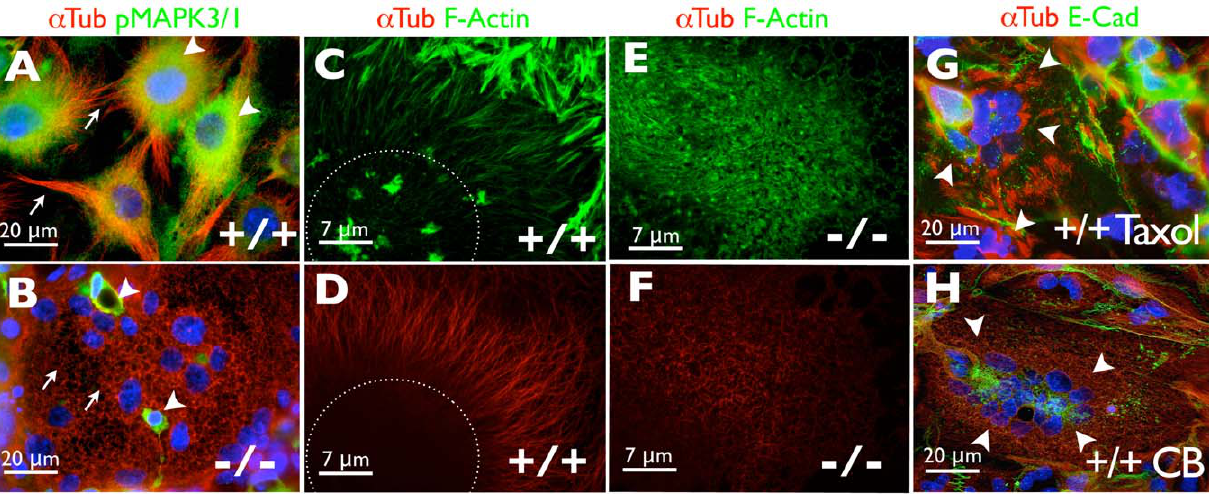
Figure 4. MAP2K1/2 inhibition and cytoskeletal rearrangement in differentiating HIF-null TSCs. Immunofluorescence microscopy of terminally differentiated wild-type ( + / + ) TGCs (A) and Hif-1/2 a 2 / 2 ( 2 / 2 ) SynTs (B) with an anti a -Tubulin (red), or p-MAPK3/1 (green) antibody (arrows=microtubules, arrowheads=pMAPK3/1). (C) Confocal microscopy imaging of polymerized actin via FITC-phalloidin staining (green) or (D) a - Tubulin (red) in terminally differentiated control TGCs (dashed line indicates approximate location of nucleus). (E) Confocal microscopy imaging of polymerized actin via FITC-phalloidin staining (green) or (F) a -Tubulin (red) in terminally differentiated HIF-null SynTs. (G) Differentiation of control TSCs in the presence of Taxol (G) or (H) Cytochalasin B (CB) promoted the formation of multinucleated cells (arrowheads) following culture on TC plastic in Fib-CM. a -Tubulin (red) and E-Cadherin (green).